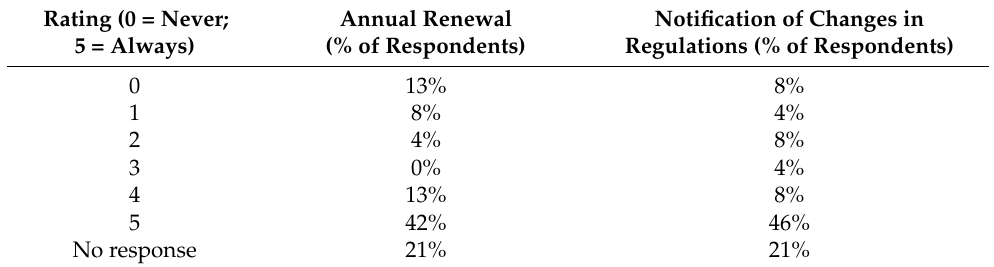
Table 3. Notification of annual renewals and changes in regulations. ( n = 24).